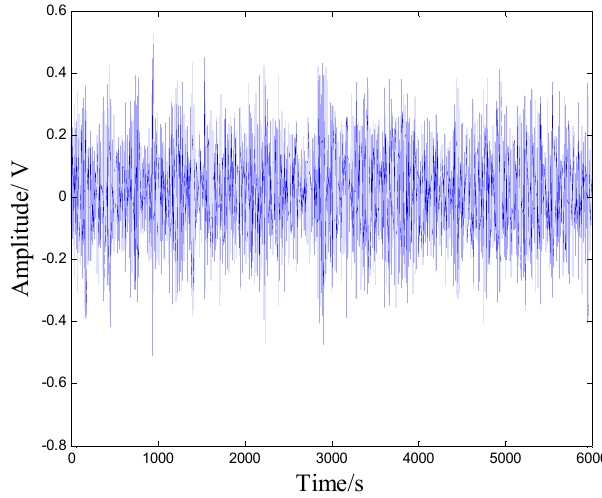
Figure 24. The time domain plot of ball defect.